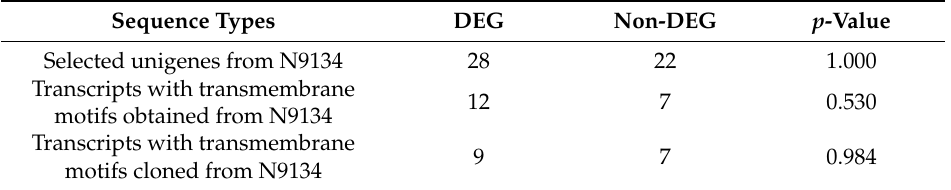
Table 3. Conformity test between number of TaNAC transcripts with transmembrane motifs and number of originally selected unigenes according to classification as DE / non-DE under fungal stress.